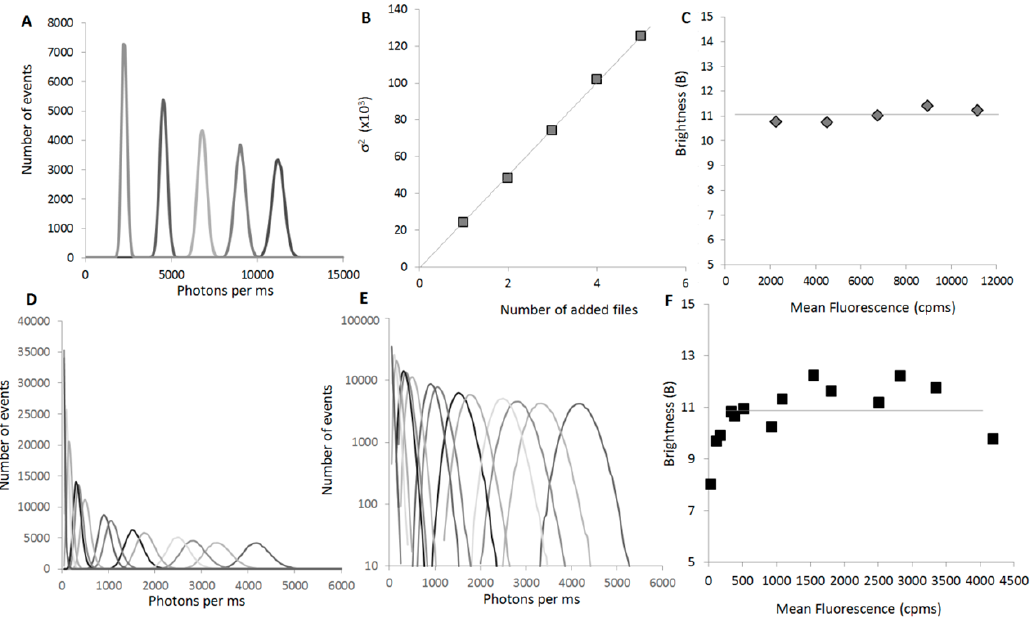
Figure 5. B is independent from the concentration: ( A ) Simulated distributions of values for a serial range of concentrations. To simulate the increase of concentration, we acquired multiple curves for the same sample (GFP monomer). We then artificially added the intensities of 2, 3, 4 or 5 different files, and analyzed the distribution of the sums. As the files are not correlated, we efficiently recreate the increase of concentrations, but not an increase of fluctuations due to oligomer formation. Curves are differentiated by using different shades of grey and black; ( B ) The calculated variance of the distribution ( σ 2 ) (grey squares) linearly increases with the concentration (or in this case, the number of files used to simulate the concentration increase); ( C ) In this simulation, the brightness parameter ( B ) (grey diamonds) does not vary with the concentration; ( D ) Experimental distributions of values for a serial range of concentrations. Here a GFP-Cherry fusion protein was expressed at different final concentrations and a 60 s fluorescent time trace was acquired for each sample. Curves are differentiated by using different shades of grey and black; ( E ) The distributions of values of ( D ) are presented in a semi-logarithmic scale to show the loss of symmetry of the distributions at low concentrations. Curves are differentiated by using the same shades of grey and black as in ( D ); ( F ) Experimental B values (black squares) as a function of the mean fluorescence. B is indeed independent of the concentration if the mean fluorescence is >400 cpms.